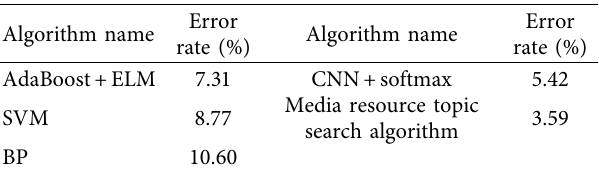
Figure 8: The relationship between the error rate of different learning rates and the number of Table 1: Comparison of error rates of several different image classification methods.